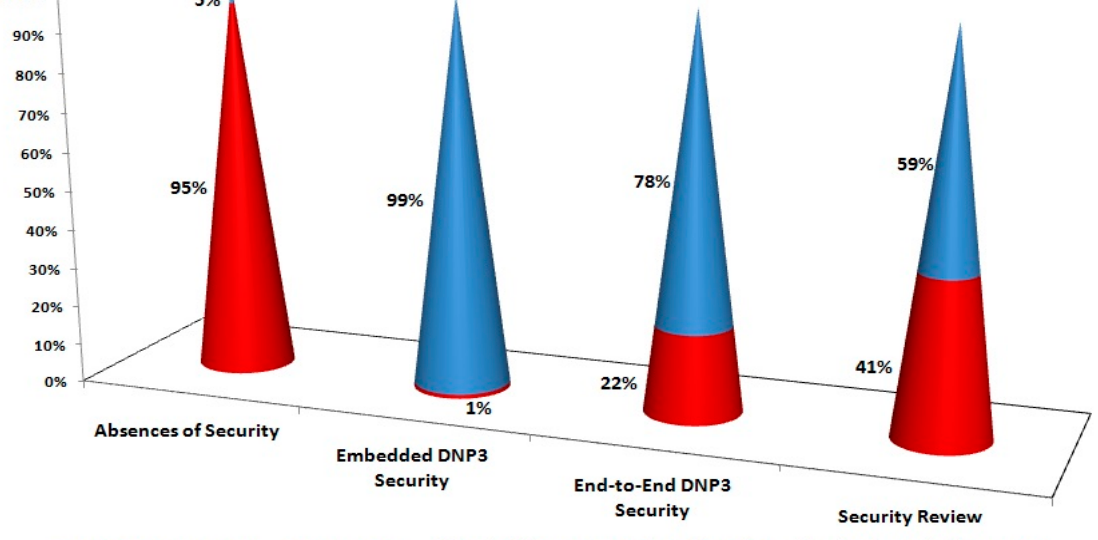
Figure 10. Security test using end-to-end DNP3 security.